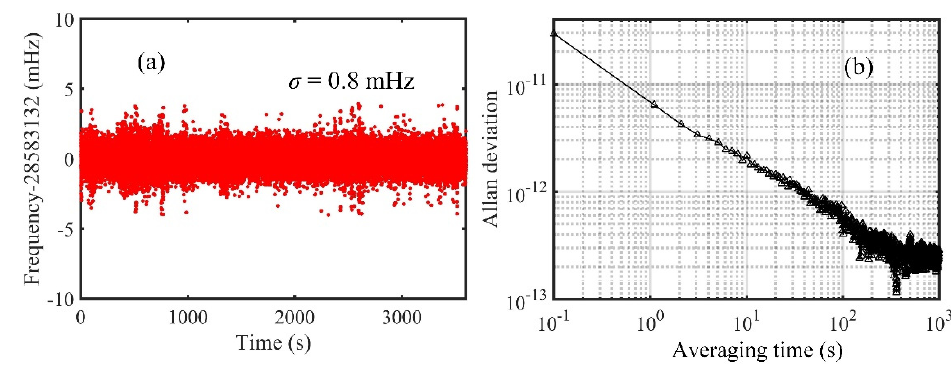
Figure 2. ( a ) Long-term measurement of the repetition frequency; ( b ) Allan deviation of the repetition frequency.